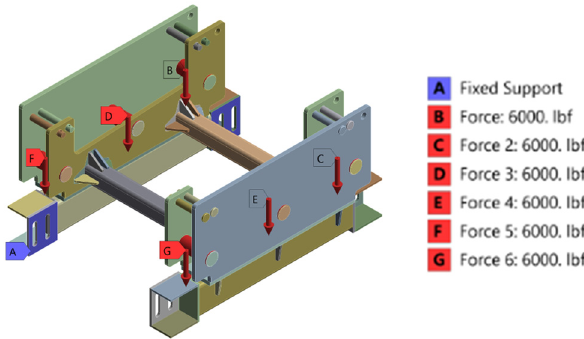
Figure 7: Load and boundary conditions for load case 2.